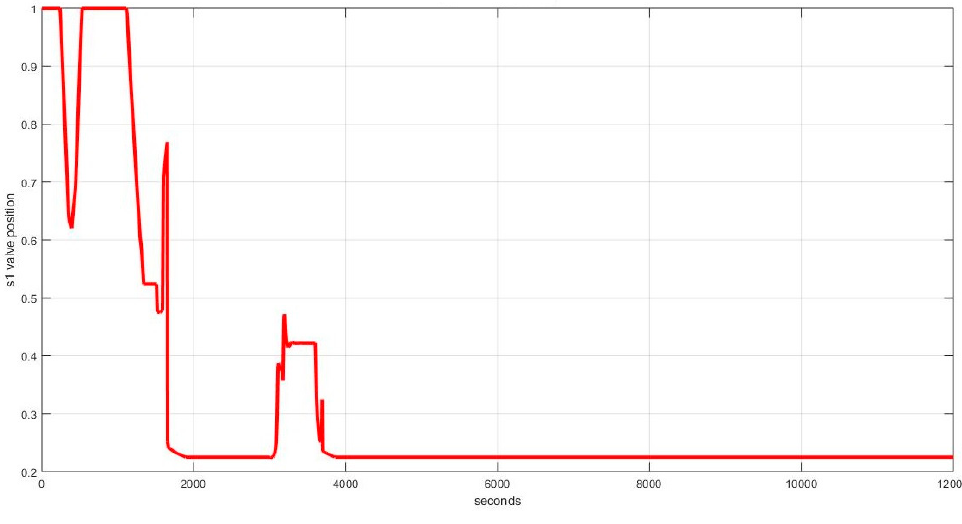
Figure 34. s1 control variable indicating the valve position for the case of negative surge.